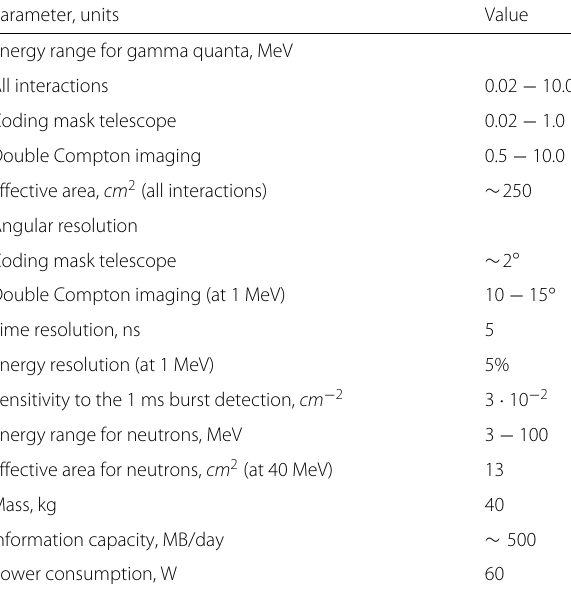
Table 2 The tracking gamma spectrometer